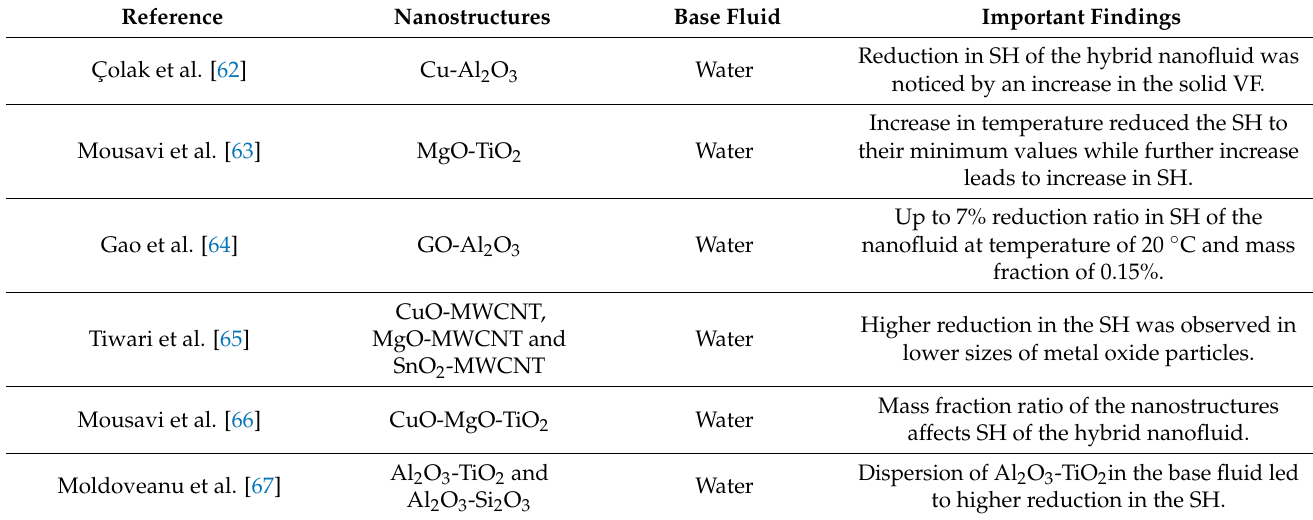
Figure 7. SH variation with temperature of MgO-TiO 2 /distilled water for different solid fractions. Adapted from Ref. [63]. Table 3. Findings of the works on the SH of hybrid